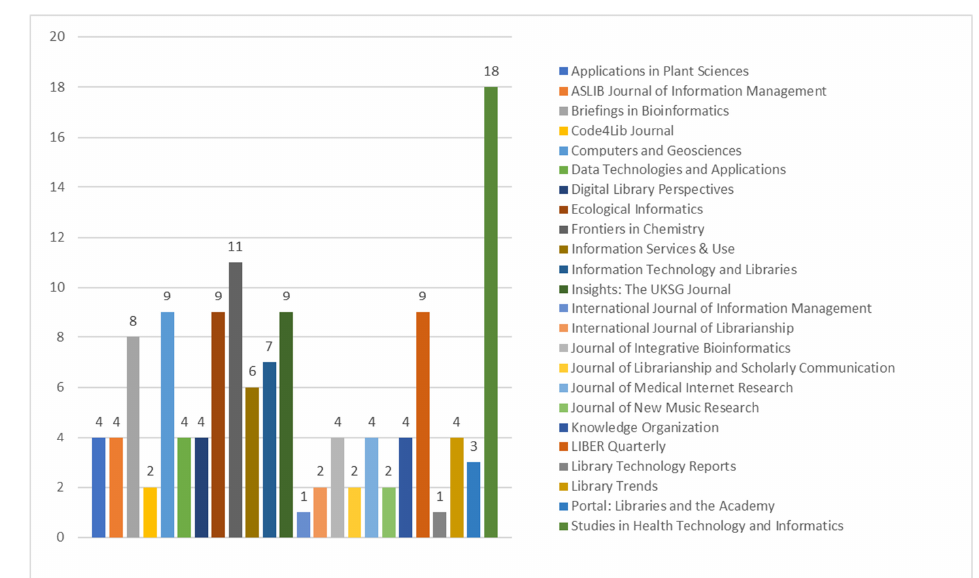
Figure A1. Authors per journal.